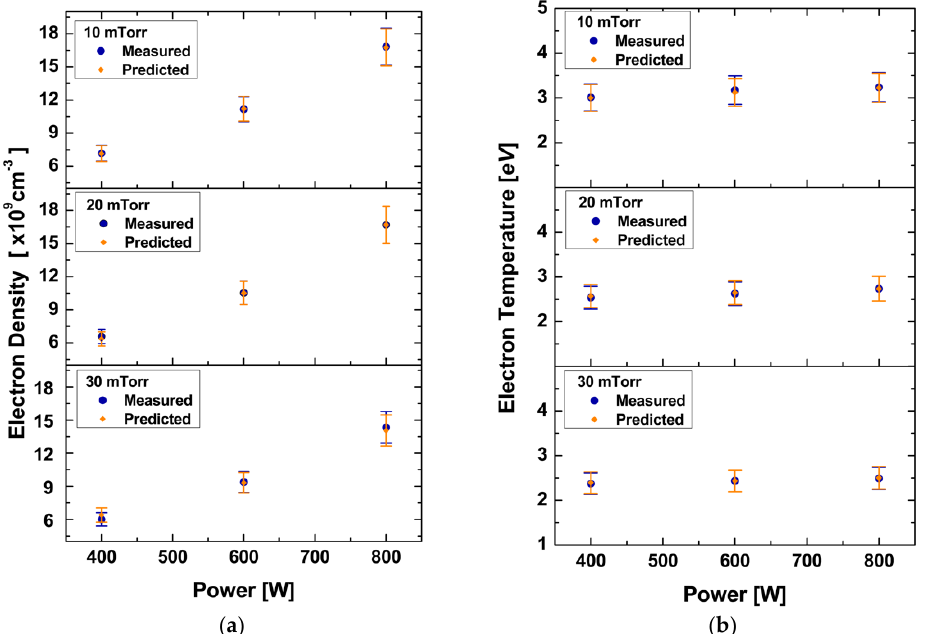
Figure 6. Comparison between the MLR method (predicted) and Langmuir probe data (measured). ( a ) is plasma electron density, ( b ) is plasma electron temperature.